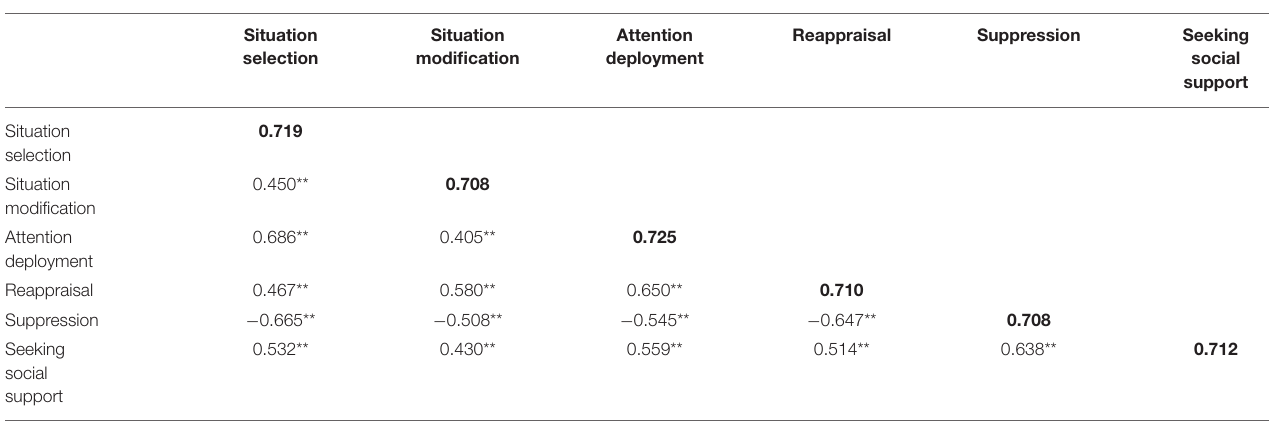
TABLE 7 | The results of discriminant